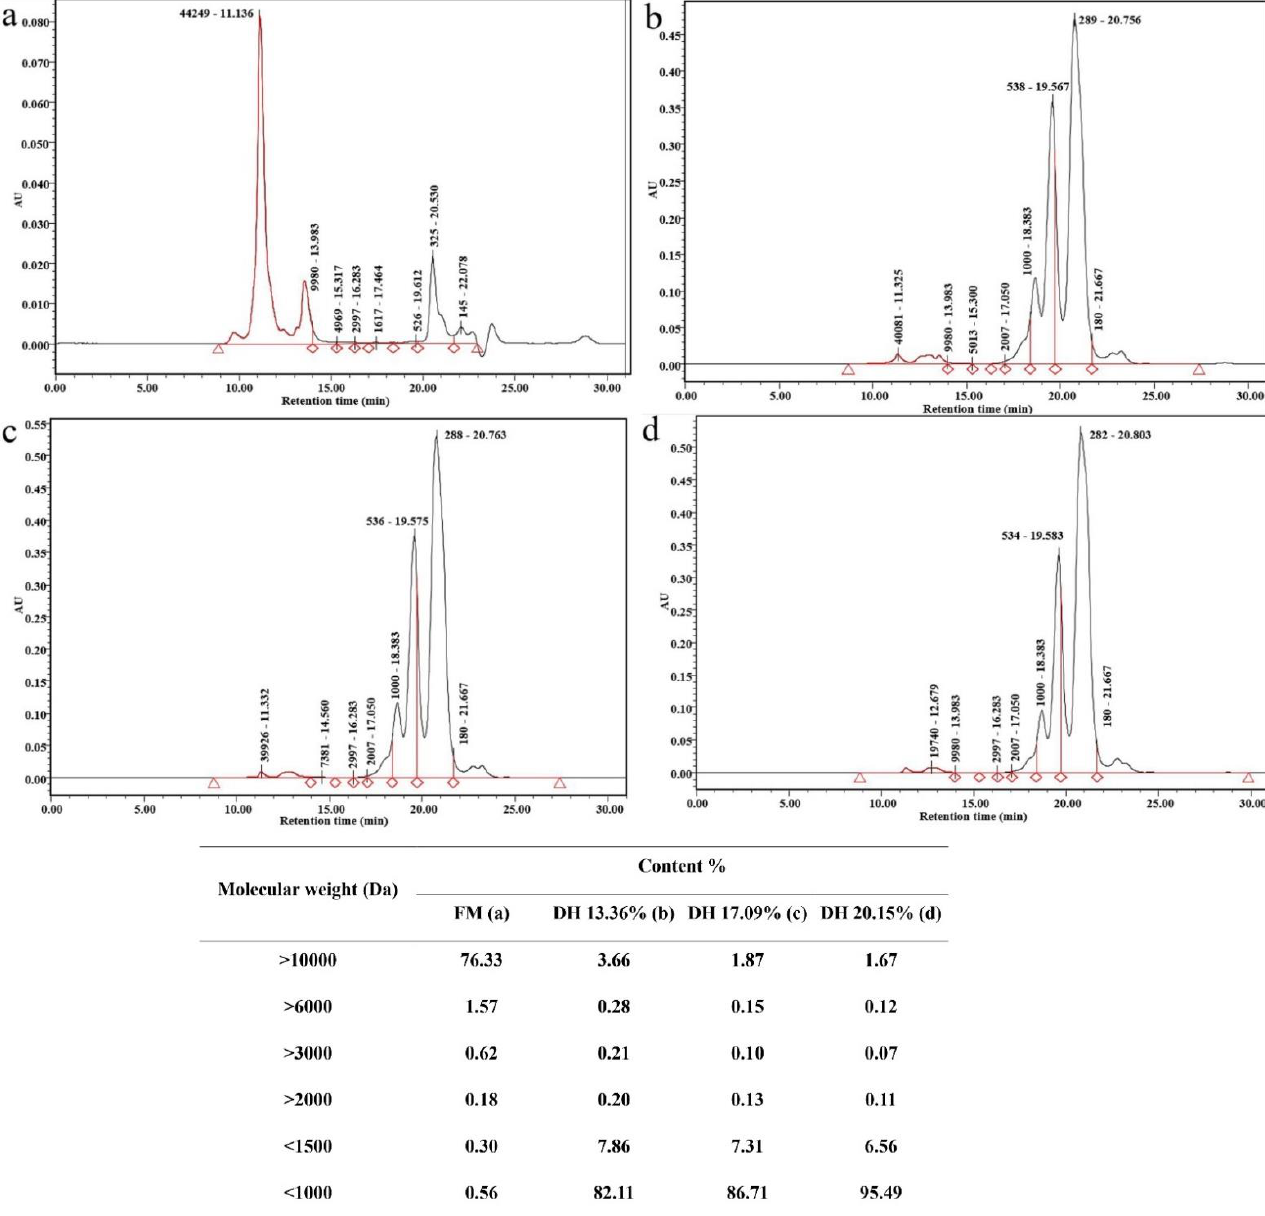
Figure 3. Molecular-weight distribution of raw and protein hydrolysates obtained from bighead carp using ficin enzyme under different times of hydrolysis: ( a ) fresh sample; ( b ) DH 13.36% (1 h); ( c ) DH 17.09% (3 h); and ( d ) DH 20.15% (6 h). However, the proportion of molecular mass with less than 1000 Da in FPH of Chinese sturgeon using the Alcalase enzyme obtained at various DH ranged from 66% to 80% [22]. Our results were higher than those reported by Rivero-Pino et al. [27], while the percentage of molecular weight <1000 Da in protein hydrolysate derived from silver carp by using Alcalase was around 60% [28]. In 2016, Stizyte, Rommi, and others reported that using protease enzymes to obtain protein hydrolysates from salmon could decrease the number of substantial molecular weight from >5000 Da to small-molecular-mass peptides (150 to 500 Da) [29]. Moreover, molecular weight <1000 Da values were higher in our study than those by Zhang et al. [30], who recorded a higher molecular weight of >5000 Da using different commercial proteases.